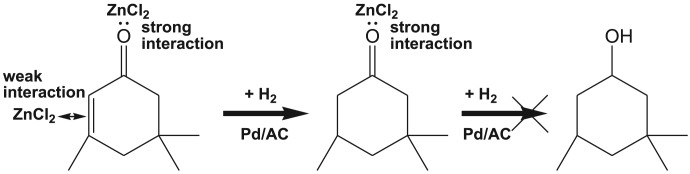
A possible mechanism of the selective hydrogenation of isophorone to TMCH by Lewis acid ZnCl2.